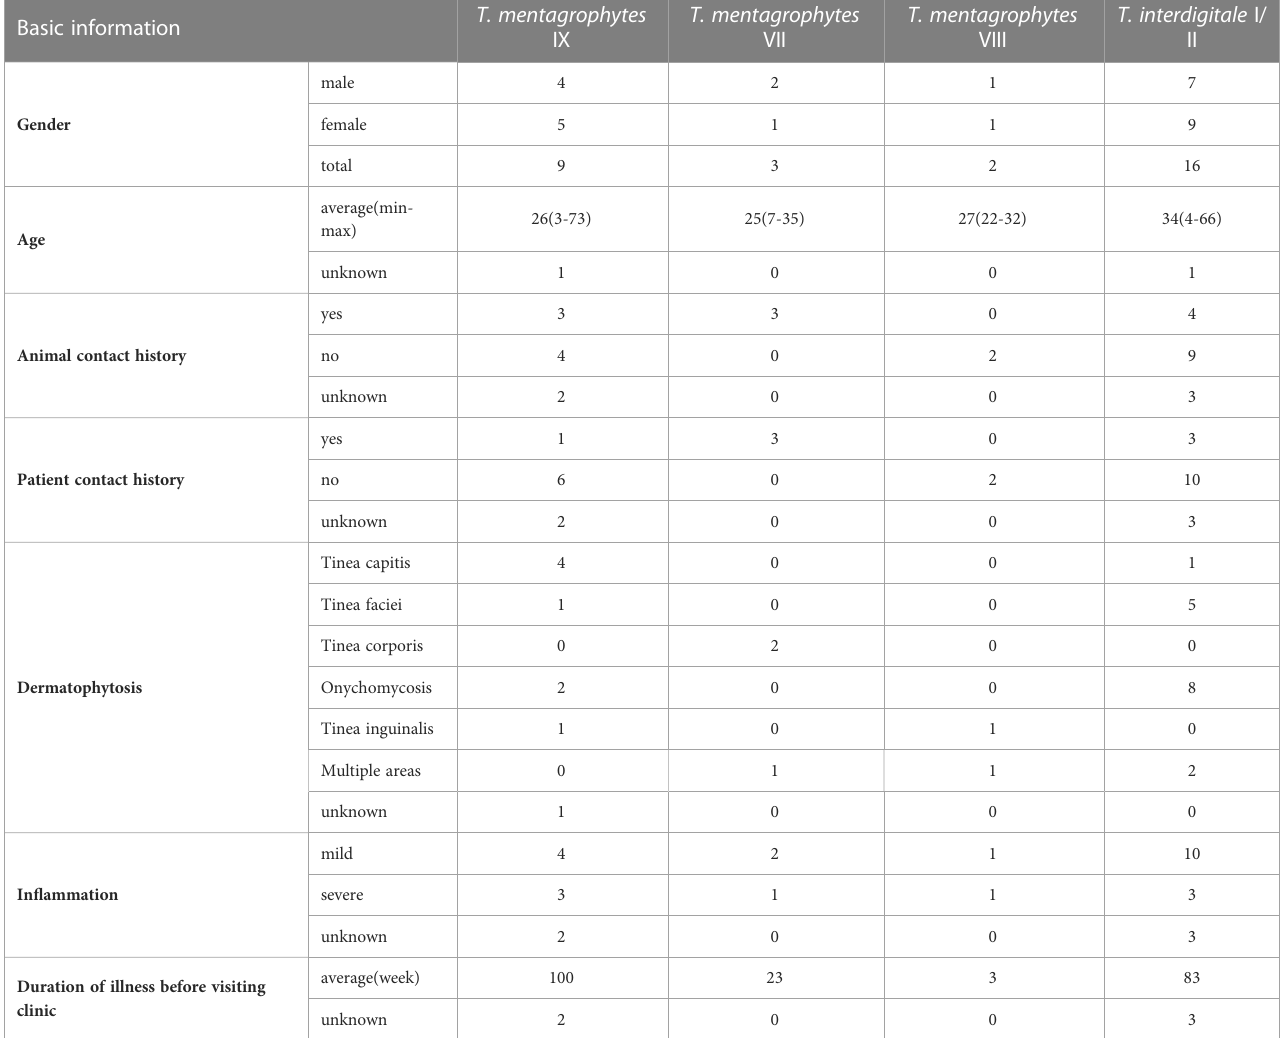
TABLE 1 Demographic and clinical data of patients with T. mentagrophyte s/ T. interdigitale complex (TMTISC) by ITS